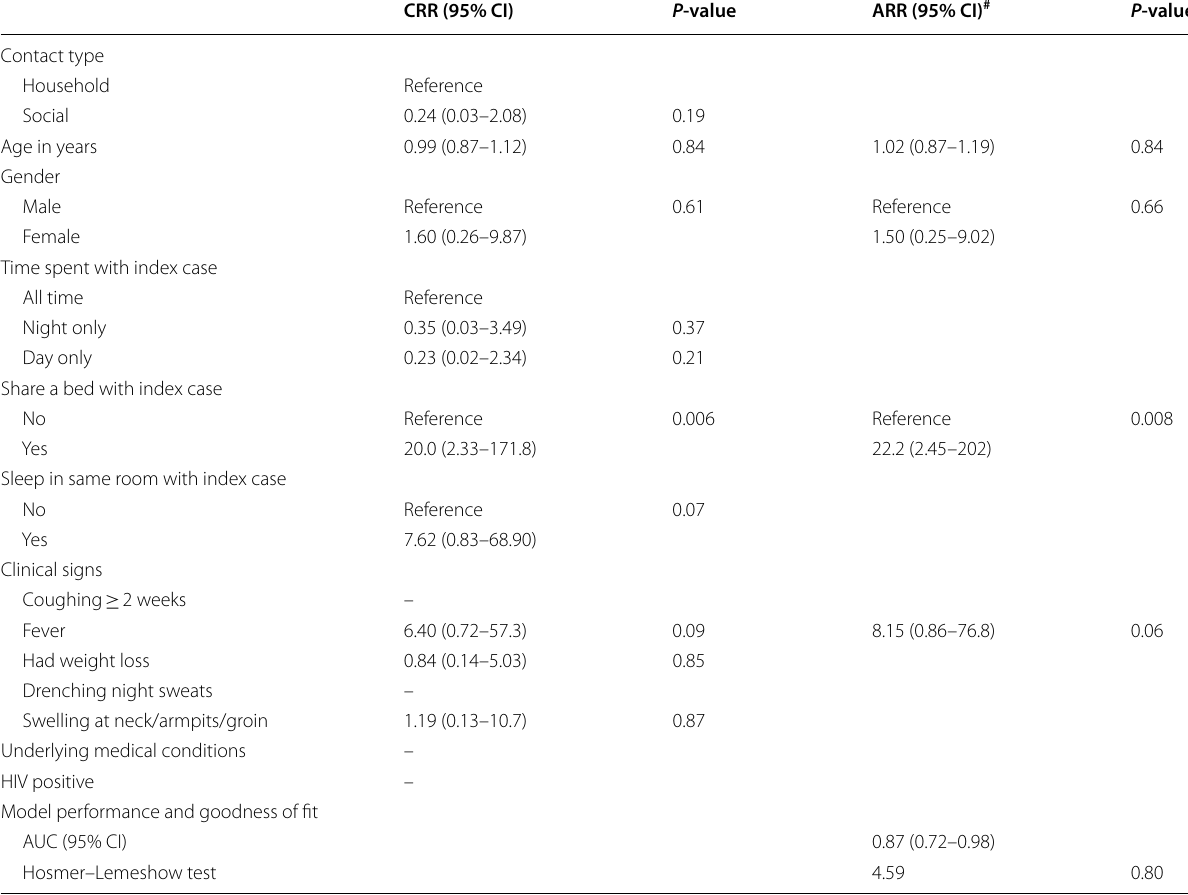
Table 4 Factors associated with contacts being GeneXpert-diagnosed TB